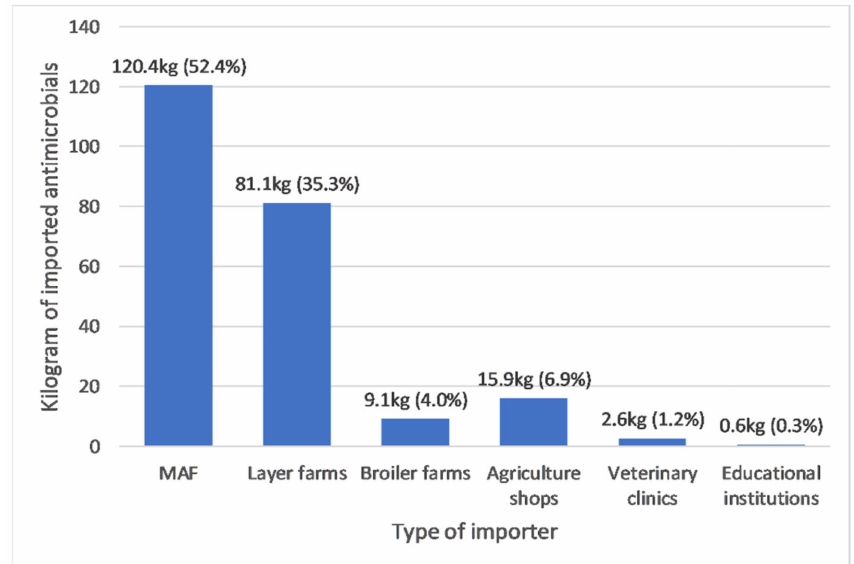
Figure 3. Total active ingredients imported between 2016 and 2019, by type of importer.